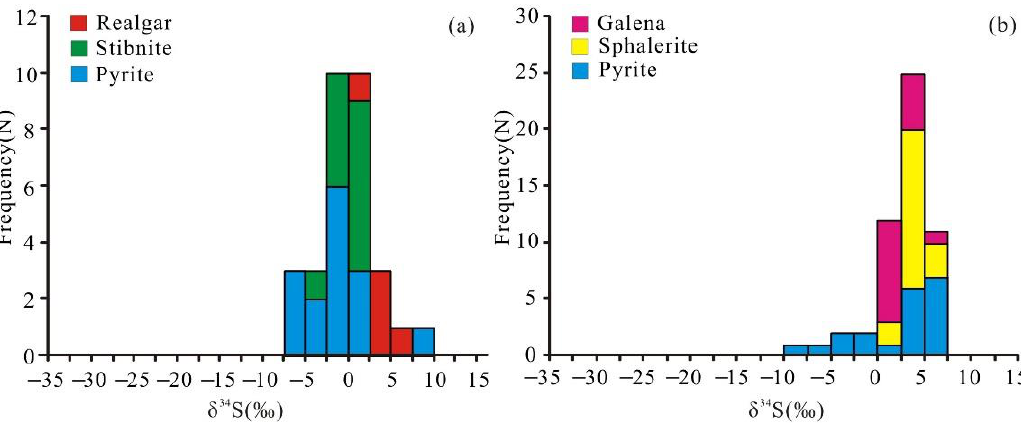
Figure 15. Histogram of the S isotope data for the Changkeng – Fuwan Au ( a )-Ag ( b ) deposit.